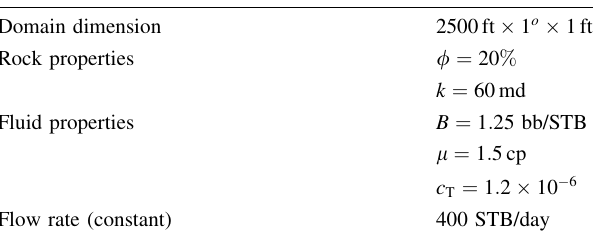
Table 1 Relevant data Domain